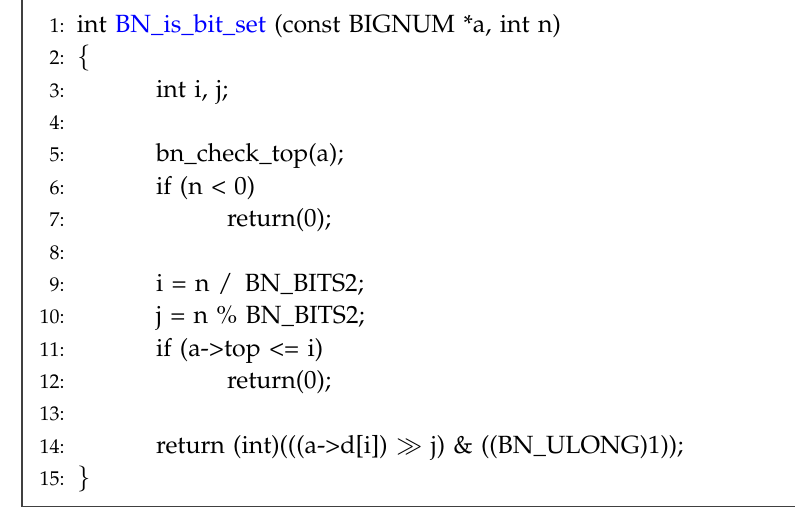
Figure A1. Key bit identification function of